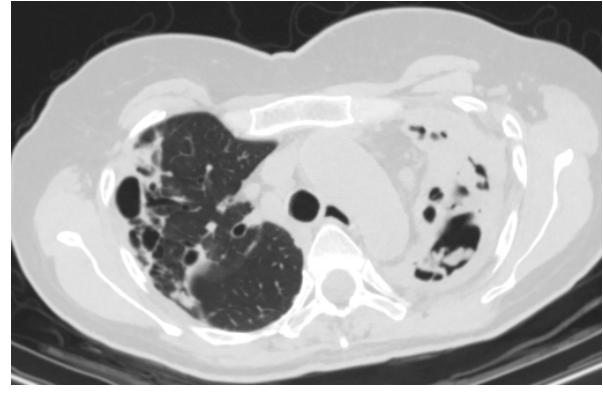
Figure 2. CCPA with involvement of the left upper lobe.